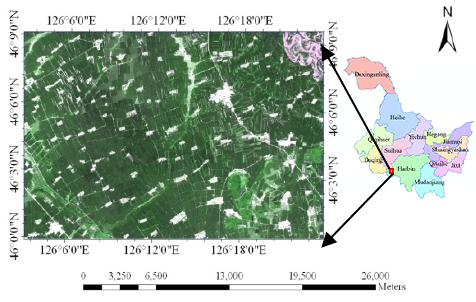
Figure 1. the study area is shown on the left image map, and the right mam is Heilongjiang province,